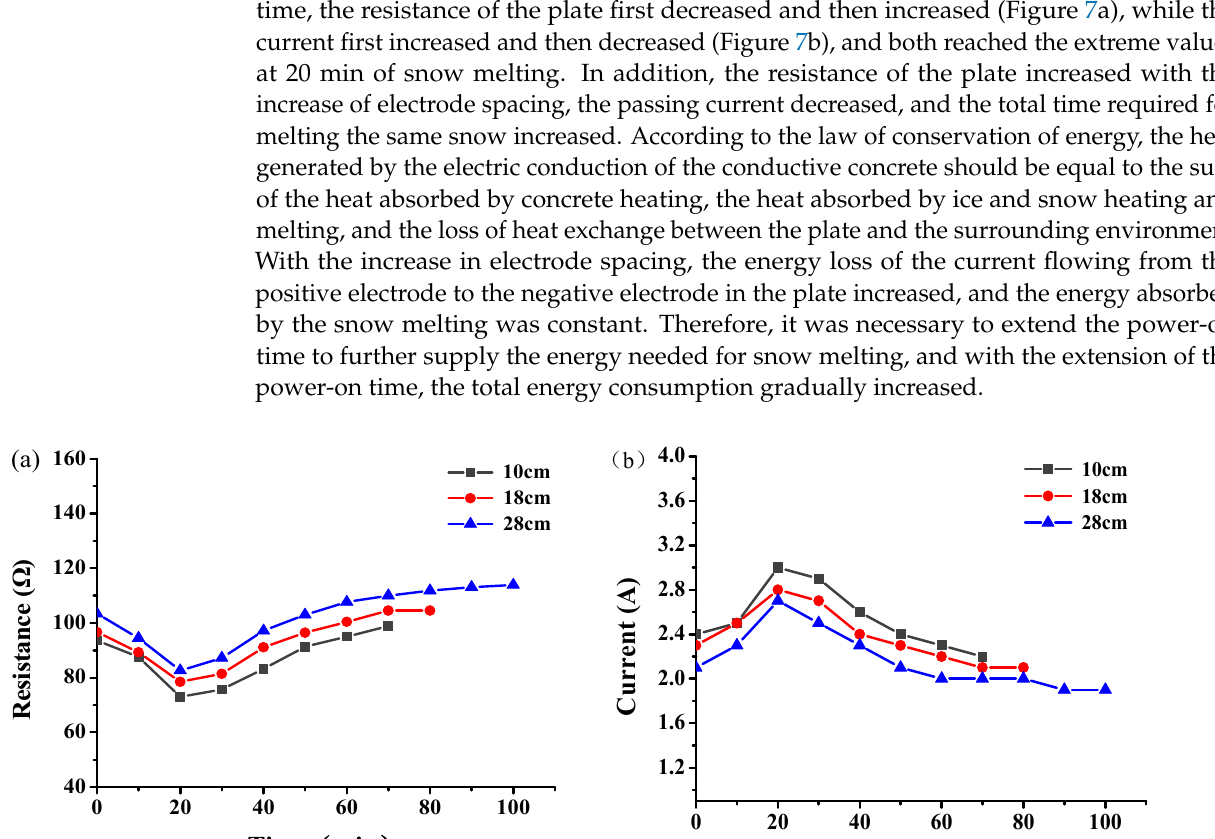
Figure 8. Input power of graphene composite conductive concrete plate with different electrode spacing.